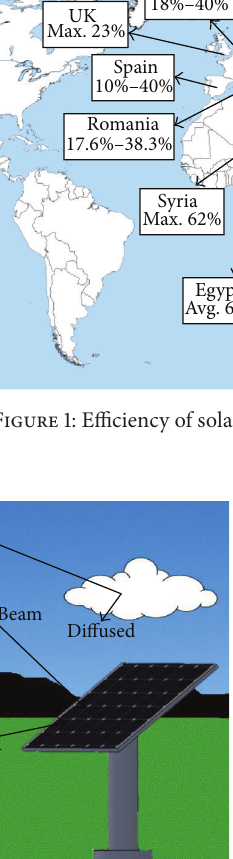
Figure 3: Circumsolar and horizon brightening components added to the isotropic component in diffusion model